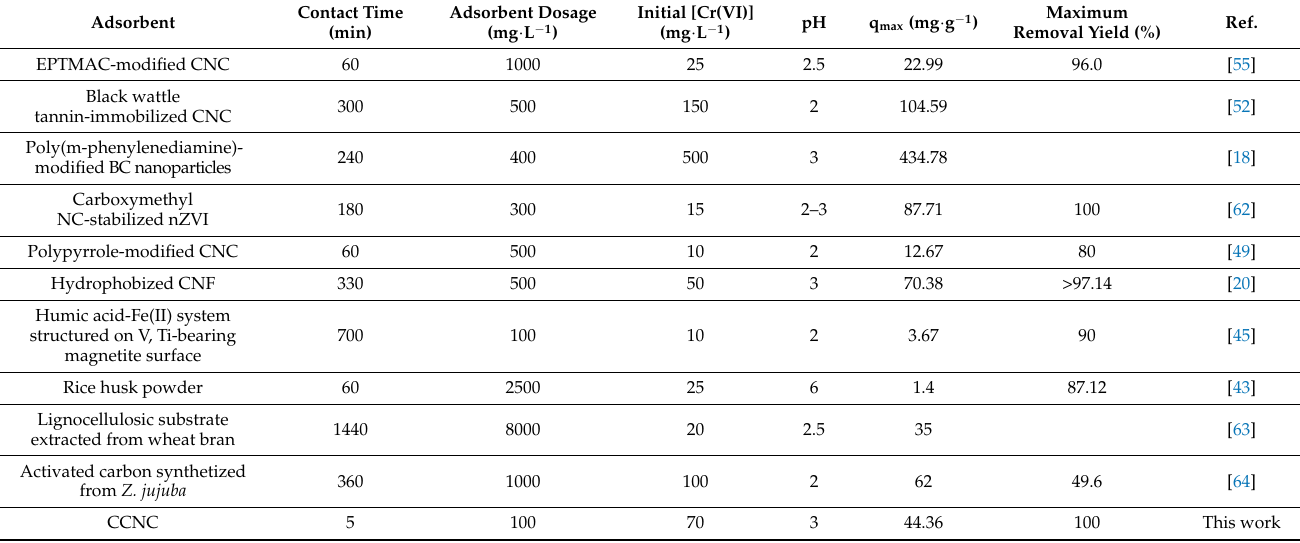
Table 3. Comparison of hexavalent adsorption treatments with different types of